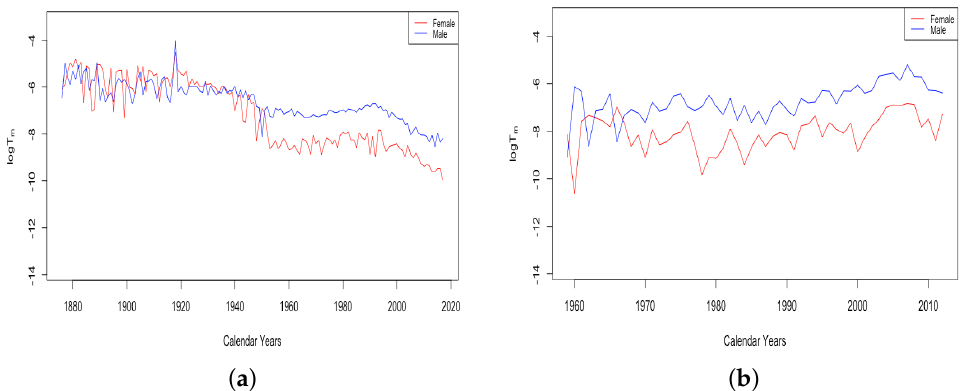
Figure 7. ( a ) The log of the limiting teenage mortality T m for Switzerland, male vs. female. ( b ) The log of the limiting teenage mortality T m for Ukraine, male vs.